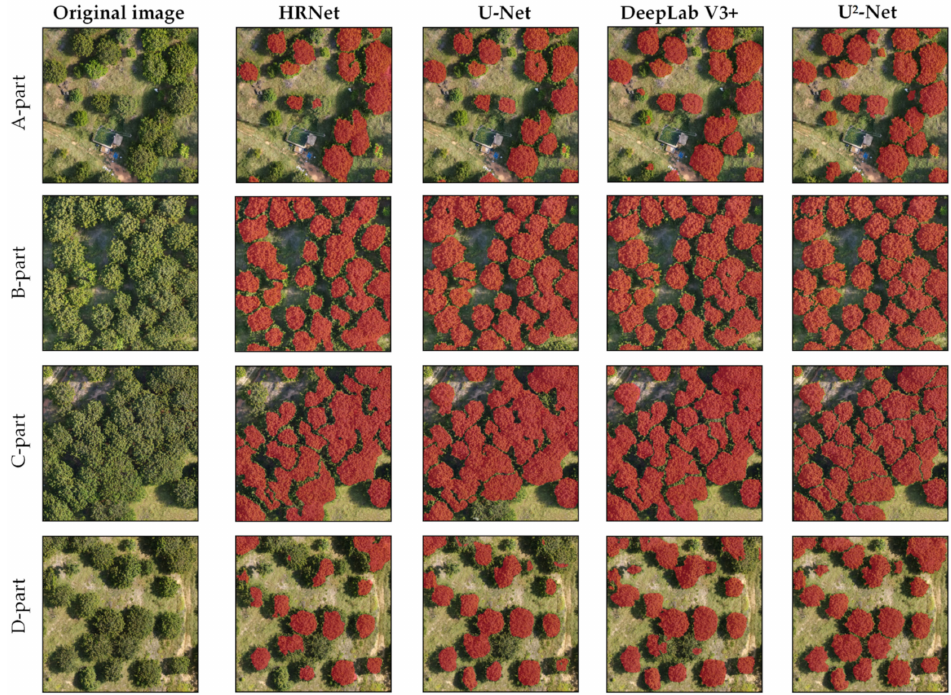
Figure 12. Segmentation results of olive tree crown for the different models. The red mask area in the figure represents the overlay prediction results for each